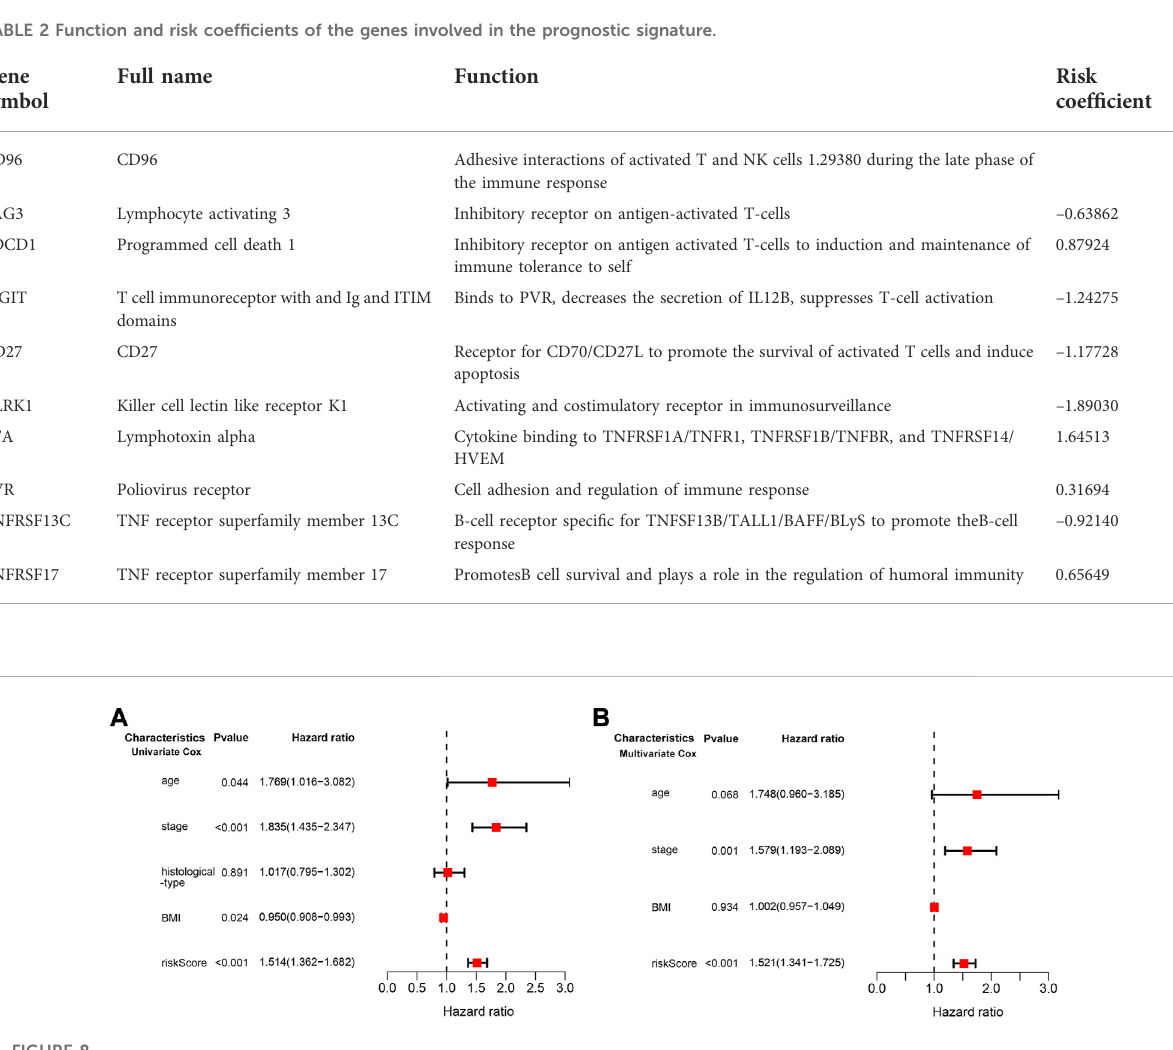
FIGURE 8 Cox regression analysis of the association between clinical factors and OS in the CESC cohorts. (A) The forest map from the univariate Cox regression analysis. (B) The forest map from the multivariate Cox regression